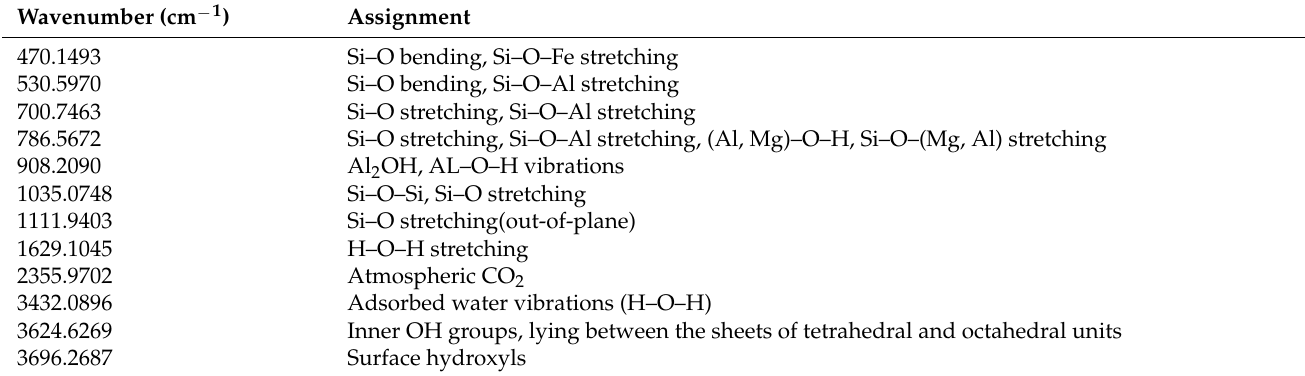
Table 4. Assignment of the bands in the powder infrared spectrum of clay samples.